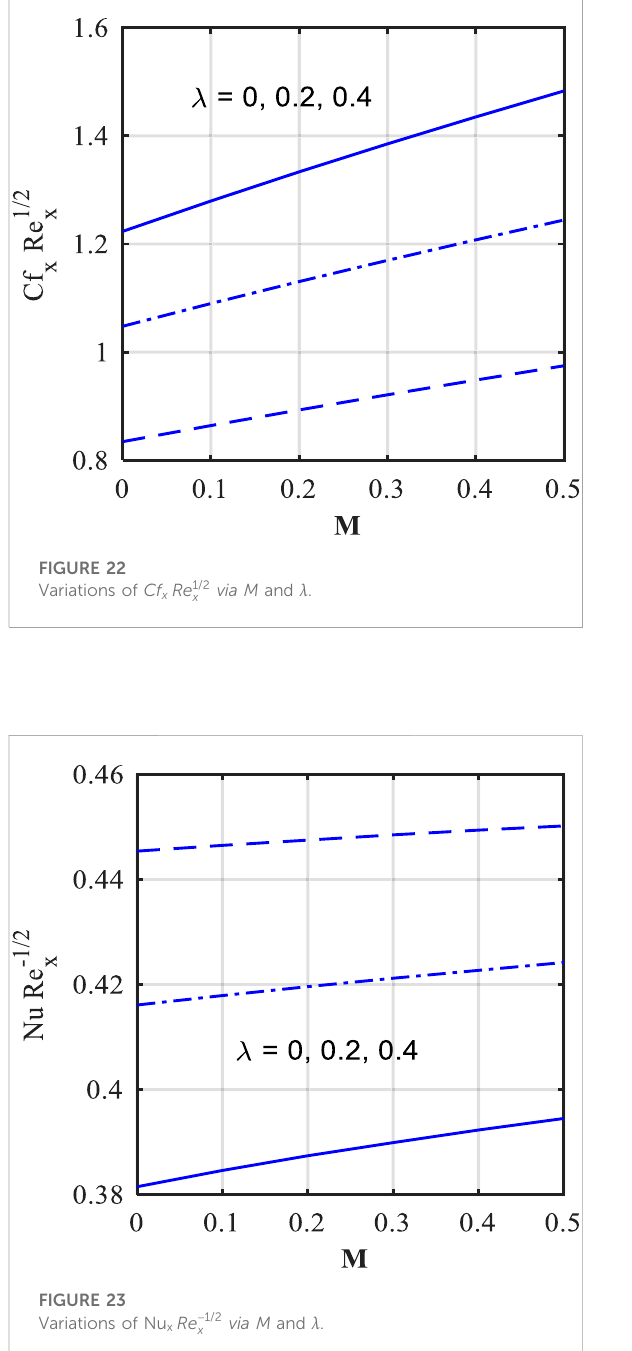
FIGURE 23 Variations of Nu x Re − 1/2 x via M and λ .